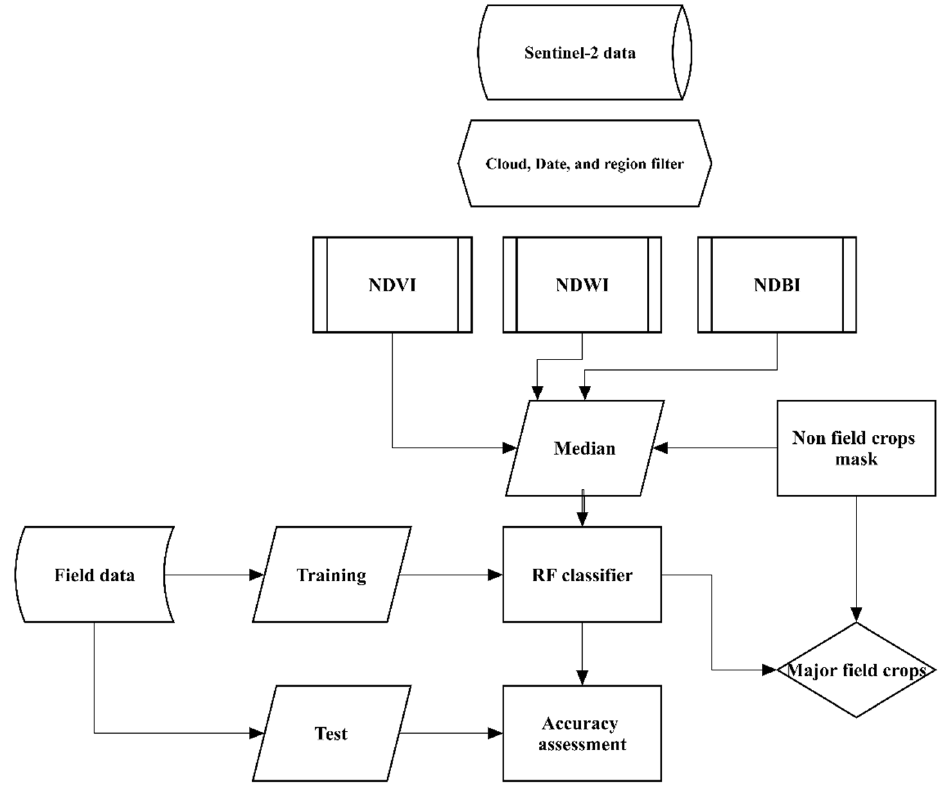
Figure 4. A simple diagram representing steps of the methodology applied by GEE to classify the major field crops for seasons in the Beni Suef governorate.